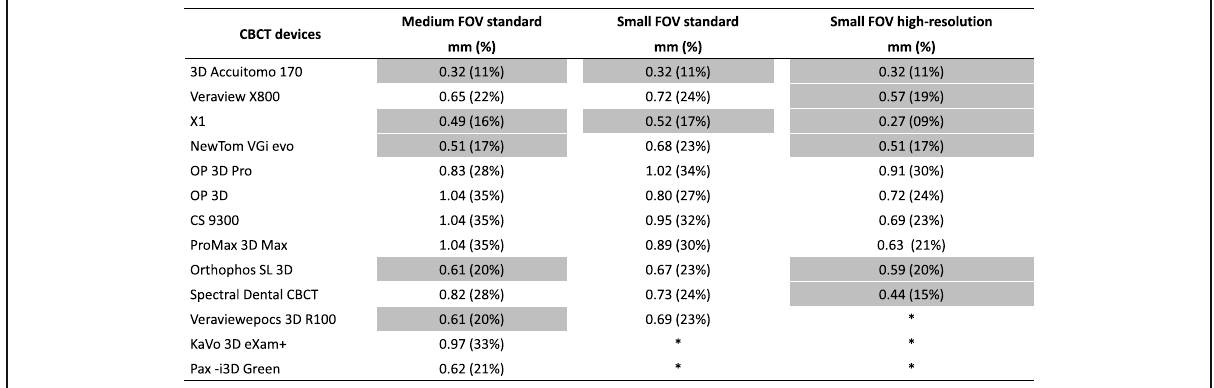
Fig. 3 Blooming artefact in millimetres and percentage increase of implant diameters compared with reference image for all studied CBCT devices and scanning protocols. The cells highlighted with light grey indicate that the implant measurements did not differ significantly from those of the reference image. Asterisks indicate the unavailable